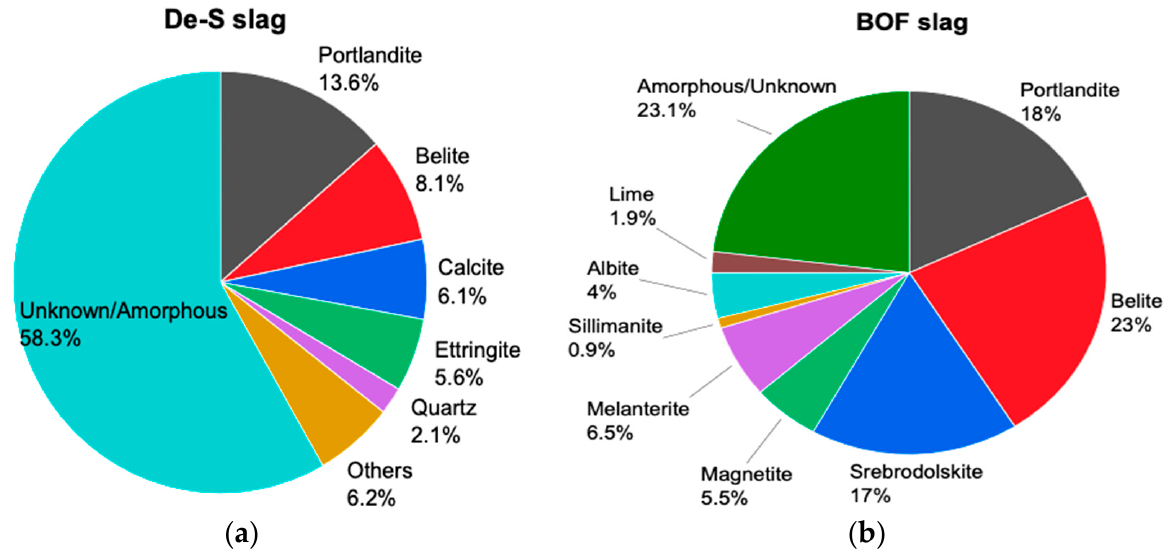
Figure 2. Mineralogy of ( a ) De-S slag and ( b ) BOF slag determined by QXRD.